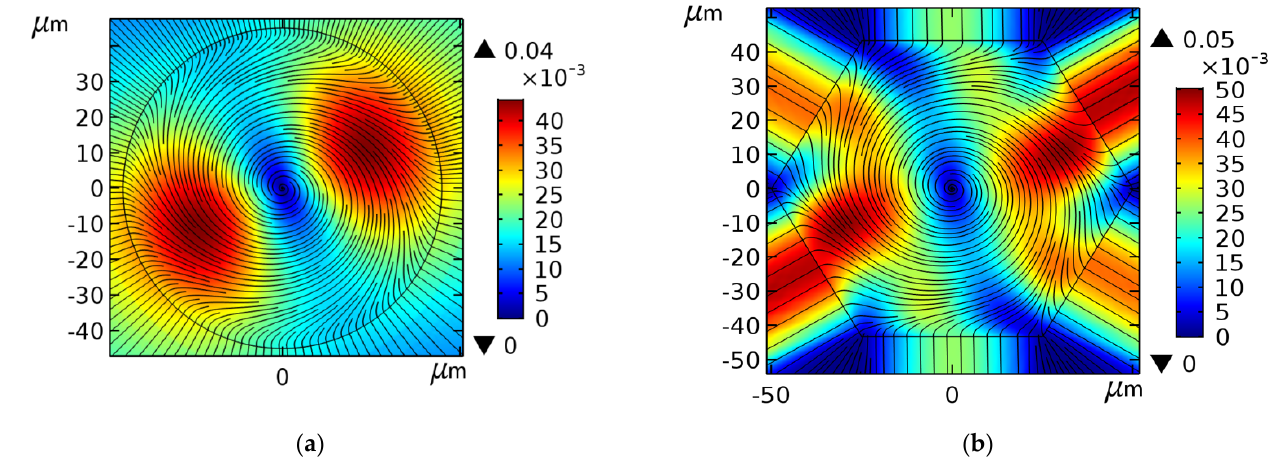
Figure 4. Radial projection of the transverse component of the Poynting vector of the fundamental air core mode at a wavelength of 3.39 µm for two air core waveguides: ( a ) air hole in an infinite dielectric layer (Figure 2a); ( b ) air core hexagon in an infinite dielectric layer (Figure 2b).